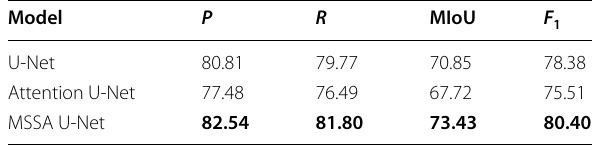
Table 6 Comprehensive evaluation indexes obtained by three networks for the “VOC2012”